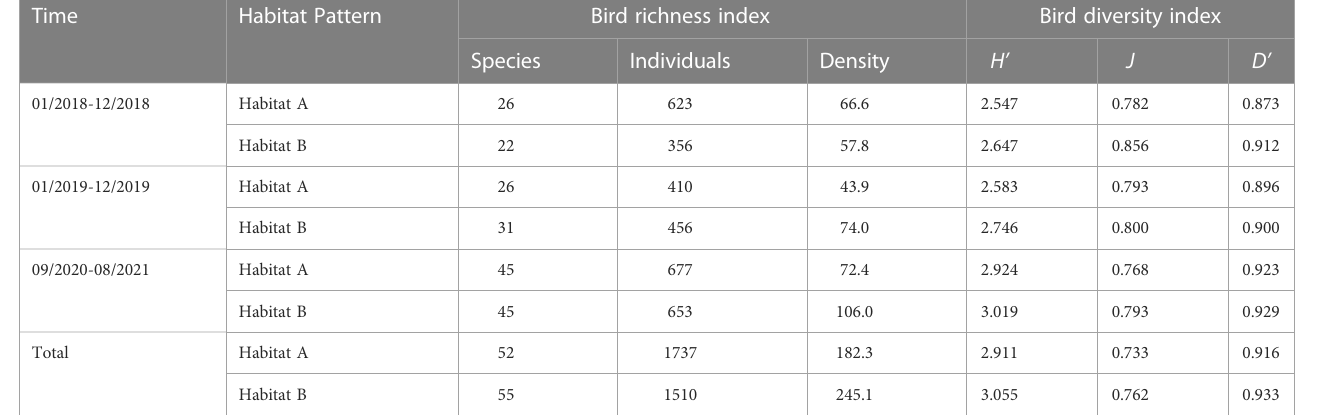
TABLE 3 The records of bird diversity during the research.